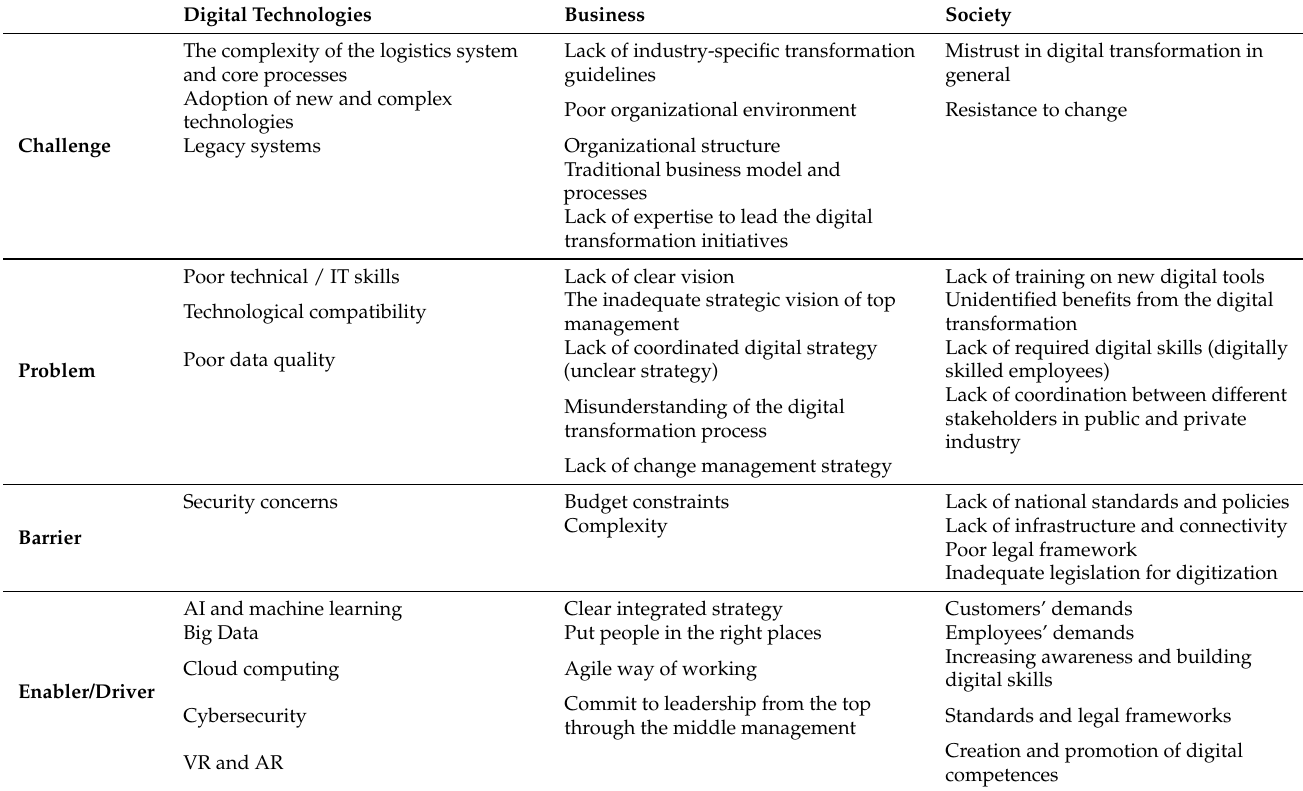
Table 4. Enablers, challenges, problems, and barriers to digital